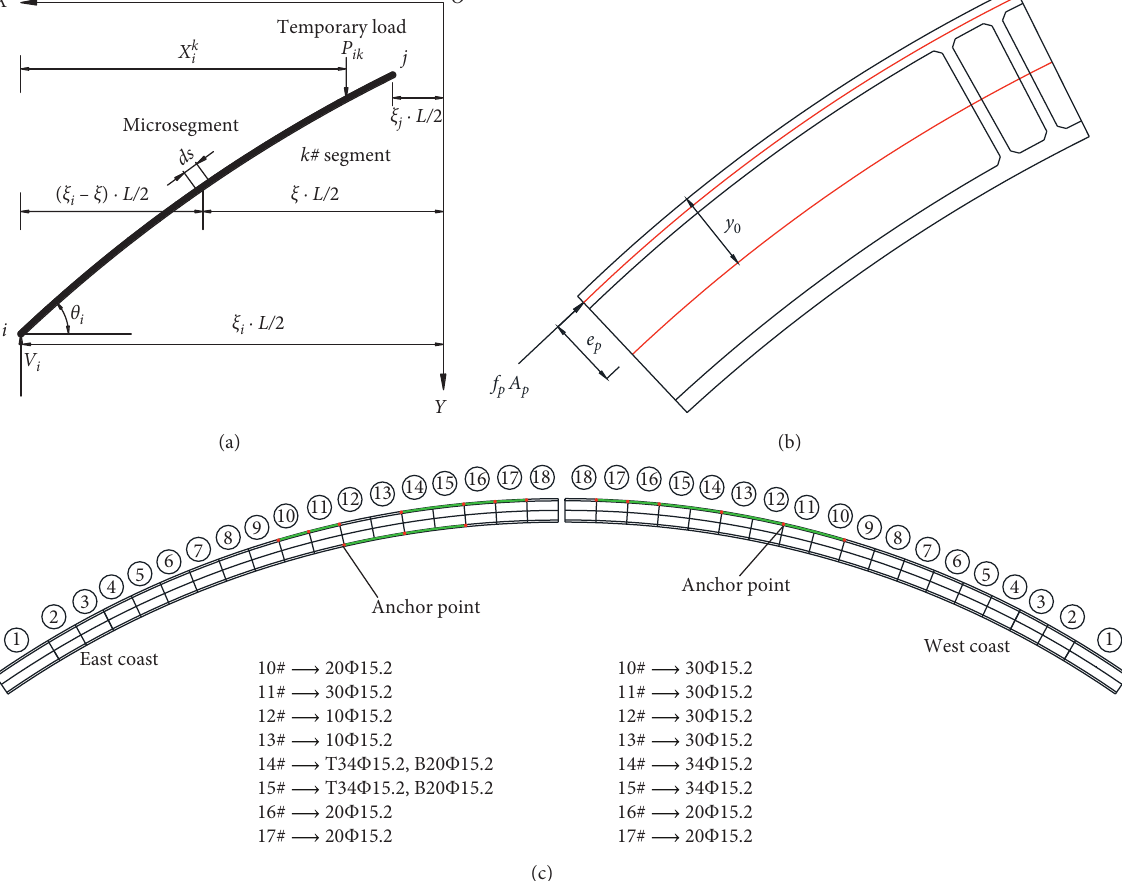
Figure 9: Principle of temporary short prestressing design for the main arch ring segment and tentative layout of the prestressed tendons for the field test study. T, B denote the top and bottom plates of the arch box-girder, respectively. (a) Force equilibrium of no. k arch ring segment. (b) Diagram of arch ring prestressing. (c) Longitudinally different patterns of prestressed tendons for field test